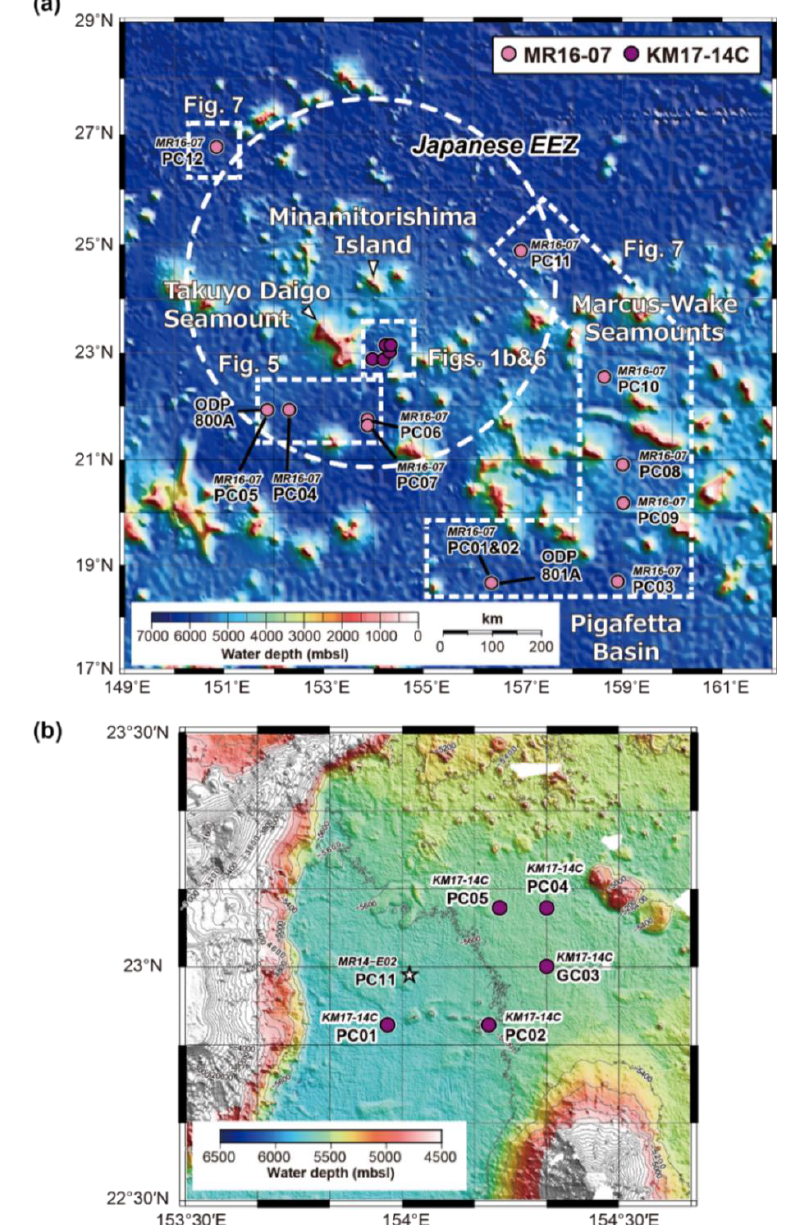
Figure 1. Locations of the piston core sites and bathymetry around Minamitorishima Island and Takuyo Daigo Seamount: ( a ) broad map and ( b ) detailed map east of Takuyo Daigo Seamount. Different research cruises are distinguished by color coding. Bathymetric data are from ETOPO1 (NOAA National Centers for Environmental Information; NCEI, https://www.ngdc.noaa.gov/mgg/global/global.html). The locations of Ocean Drilling Project (ODP) Sites 800A and 801A are the same as those of Site MR16-07 PC05 and Sites MR16-07 PC01 and PC02, respectively.